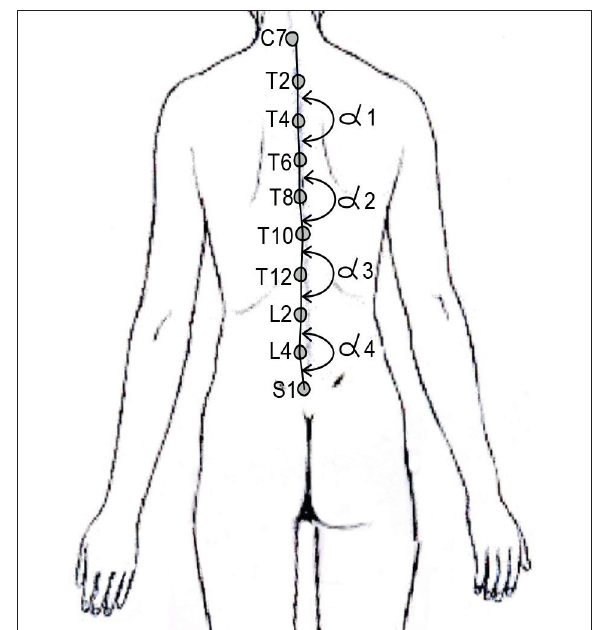
Figure 1 - Postural angles of the spine in the frontal plane: alpha angle 1, high thoracic (T2T4-T4T6), alpha angle 2, middle thoracic (T6T8-T8T10), alpha angle 3, thoracolumbar (T10T12-T12L2), and alpha angle 4, lumbar